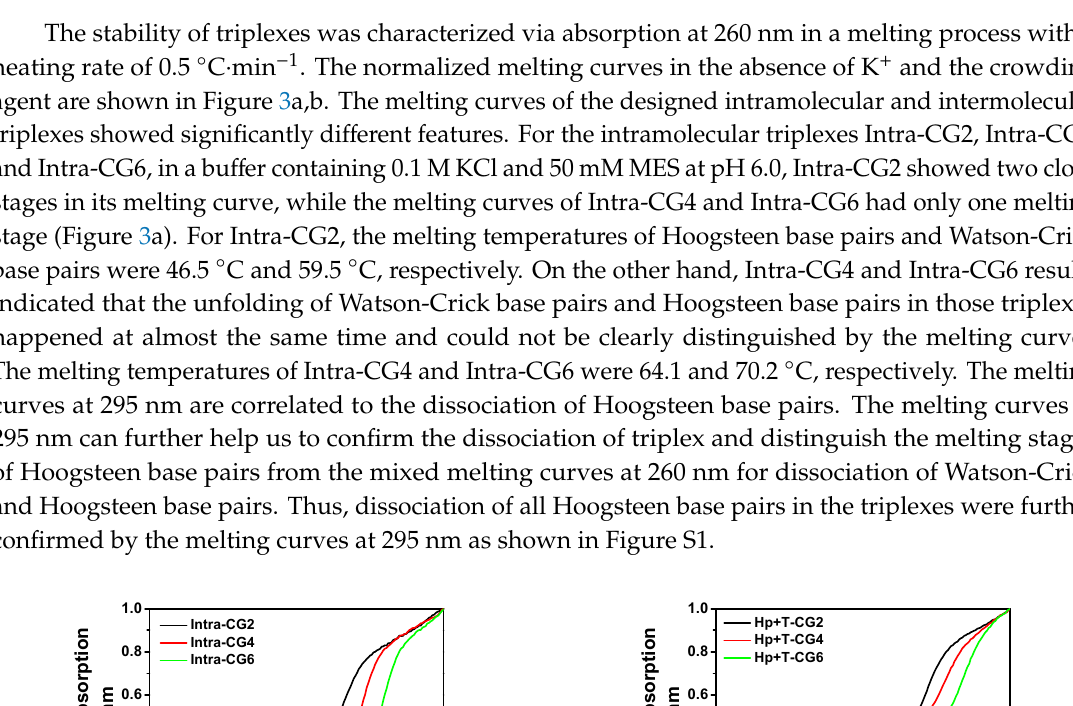
Figure 2. Circular dichroism (CD) spectra of Intra-CG2, Intra-CG4, Intra-CG6, Hp-CG2+T-CG2, Hp-